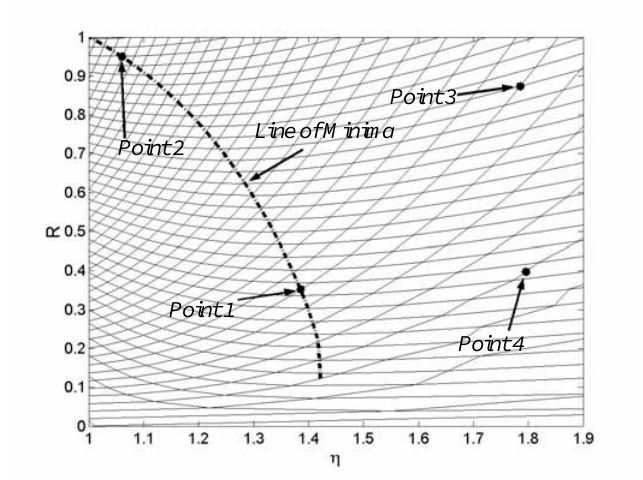
Fig. 21. Magnified view of the R - η plane illustrating the line of minima.